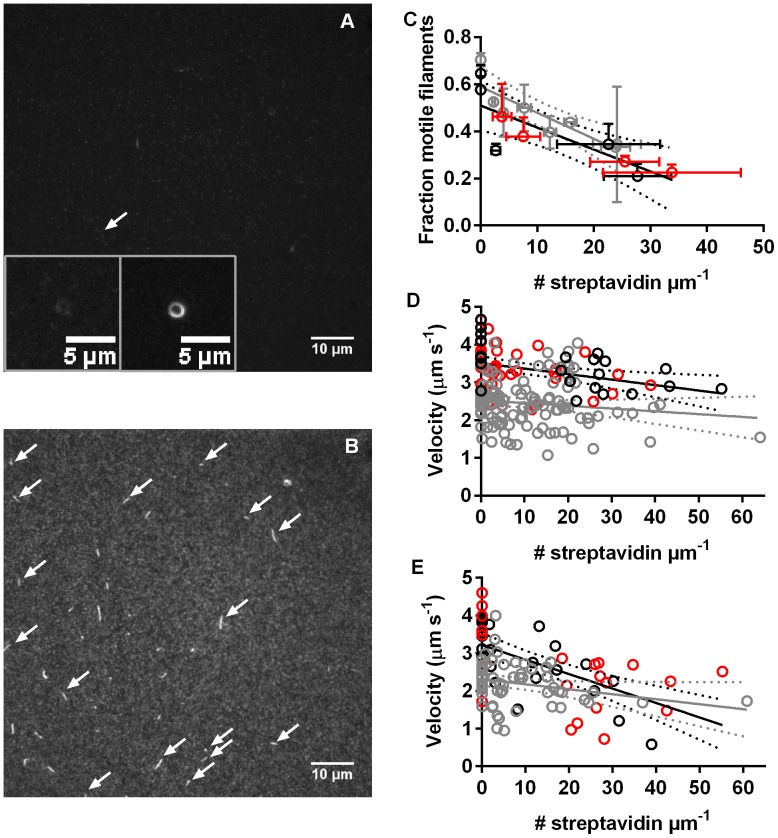
Effect of different degrees of streptavidin labelling on HMM induced actin filament motility.
A. Biotinylated and APh labelled F-actin (5 nM), immobilized to HMM on a surface, then incubated with 1 nM TRITC-streptavidin for 1 min followed by rinsing and incubation by AMc130 assay solution. Observation using TRITC filter set. Arrow indicates motile TRITC-streptavidin labelled filament. Other filament-like objects represent cross-linked and non-motile filaments. Inset: nanospool of actin filament formed by intra-filament biotin-streptavidin cross-linking. Left image, TRITC-filter set to observe TRITC-streptavidin. Right image, FITC-filter set to observe Alexa-488-labelling of the same filament. B. Same conditions as in A except for incubation with 20 nM TRITC-streptavidin and 40 µM biotin in solution. Arrows indicate motile filaments. Note, brighter background than in A, presumably due to non-specific binding of TRITC-streptavidin. C. Fraction of motile filaments vs. average number of streptavidin molecules per µm filament length. Vertical error bars: SEM. Horizontal error bars: standard deviation. D. Velocity for filaments with different number of streptavidin molecules measured during the periods of smoothest sliding (CV <0.5). E. Average velocity during 6–16 s plotted against number of streptavidin molecules per filament length. Black and grey symbols: two different experimental dates with different HMM, actin and streptavidin batches. Red symbols: covalently biotinylated F-actin with addition of 0–20 nM TRITC-streptavidin followed by 20 nM to 40 µM biotin, prior to motility assay. Same experimental date as black. Straight full lines obtained by linear regression as well as dashed lines representing 95% confidence intervals.